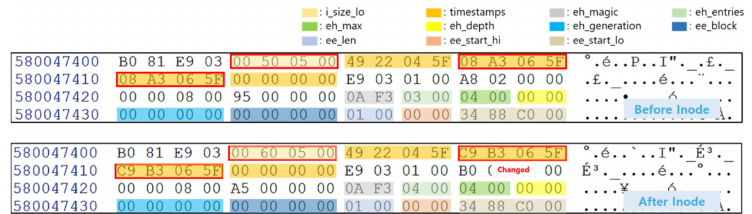
Figure 2. Comparison of mmssms.db’s inode before and after deleting app data using Scenario I. The red box indicates changed fields before and after deletion.